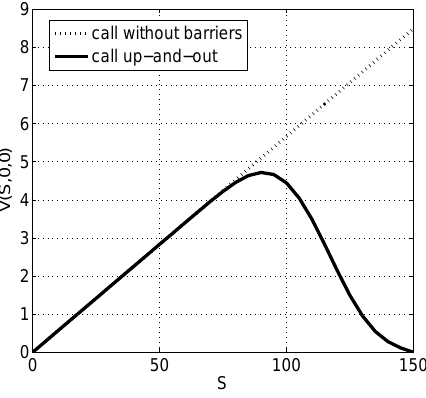
Figure 1. Semi-Analytical method for Barrier Option (SABO) approximation of a call up-and-out Figure 1. SABO approximation of a call up-and-out Geometric Asian option with floating strike and geometric Asian option with a floating strike and the data in Table data in Table 1.